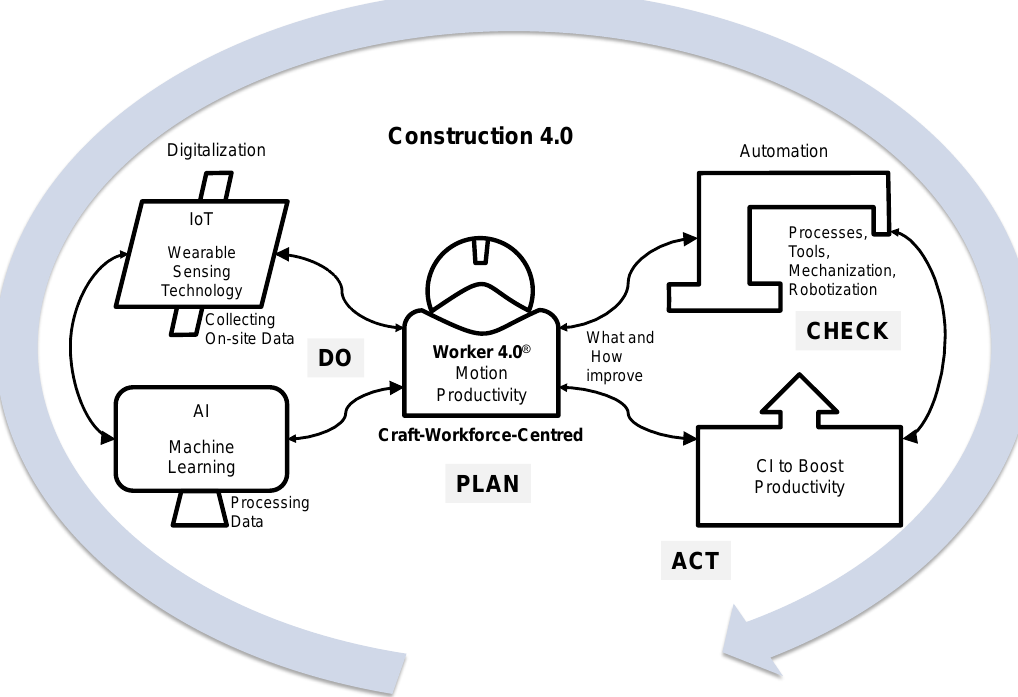
Figure 7. Worker 4.0: Craft-workforce-centered.